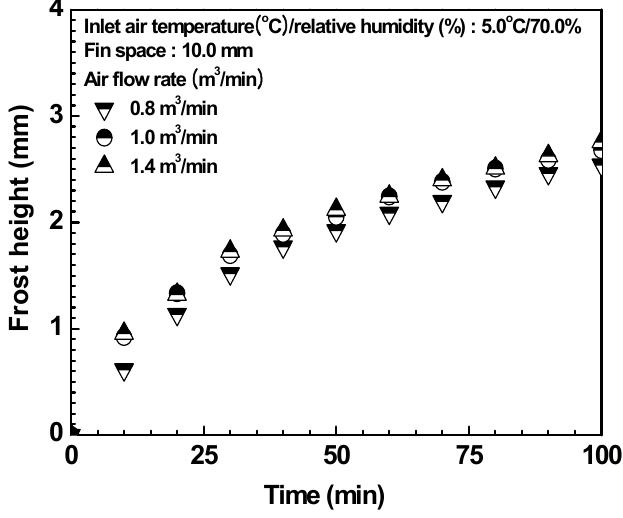
Figure 6. Frost height with the variations of the air flow